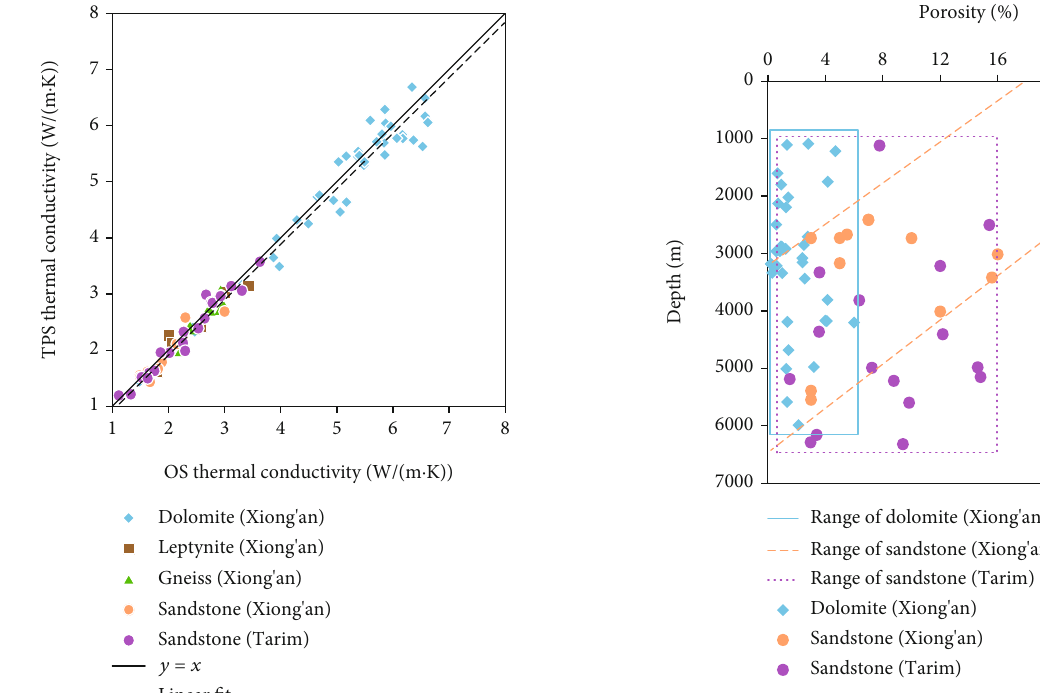
Figure 10: Distribution of porosity varied with depth.